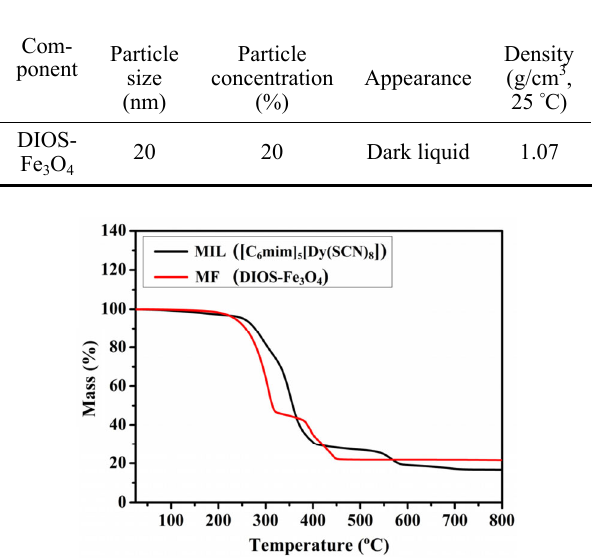
Fig. 2 TGA curves of the MIL and MF.